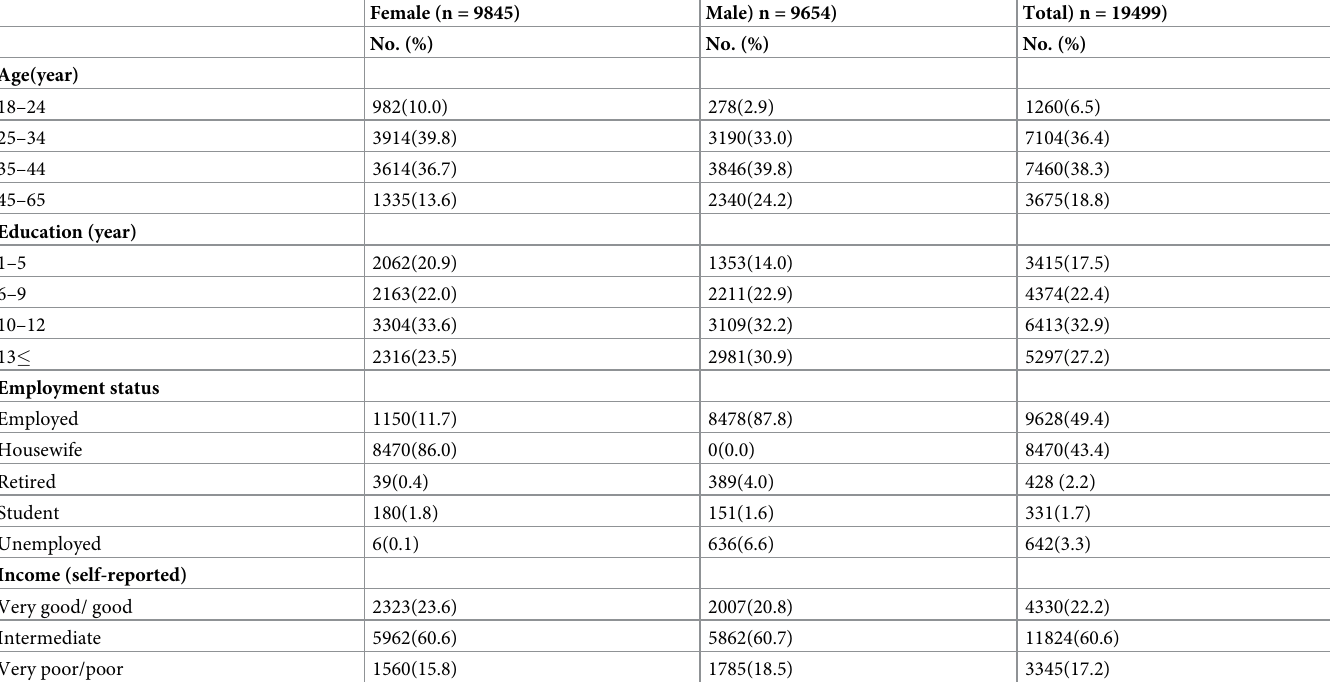
Table 1. Frequency distributions of the participants’ demographic characteristics.